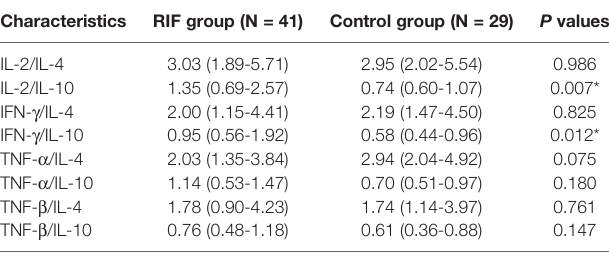
TABLE 4 | Serum Th1/Th2 ratios in the mid-luteal phase. Characteristics